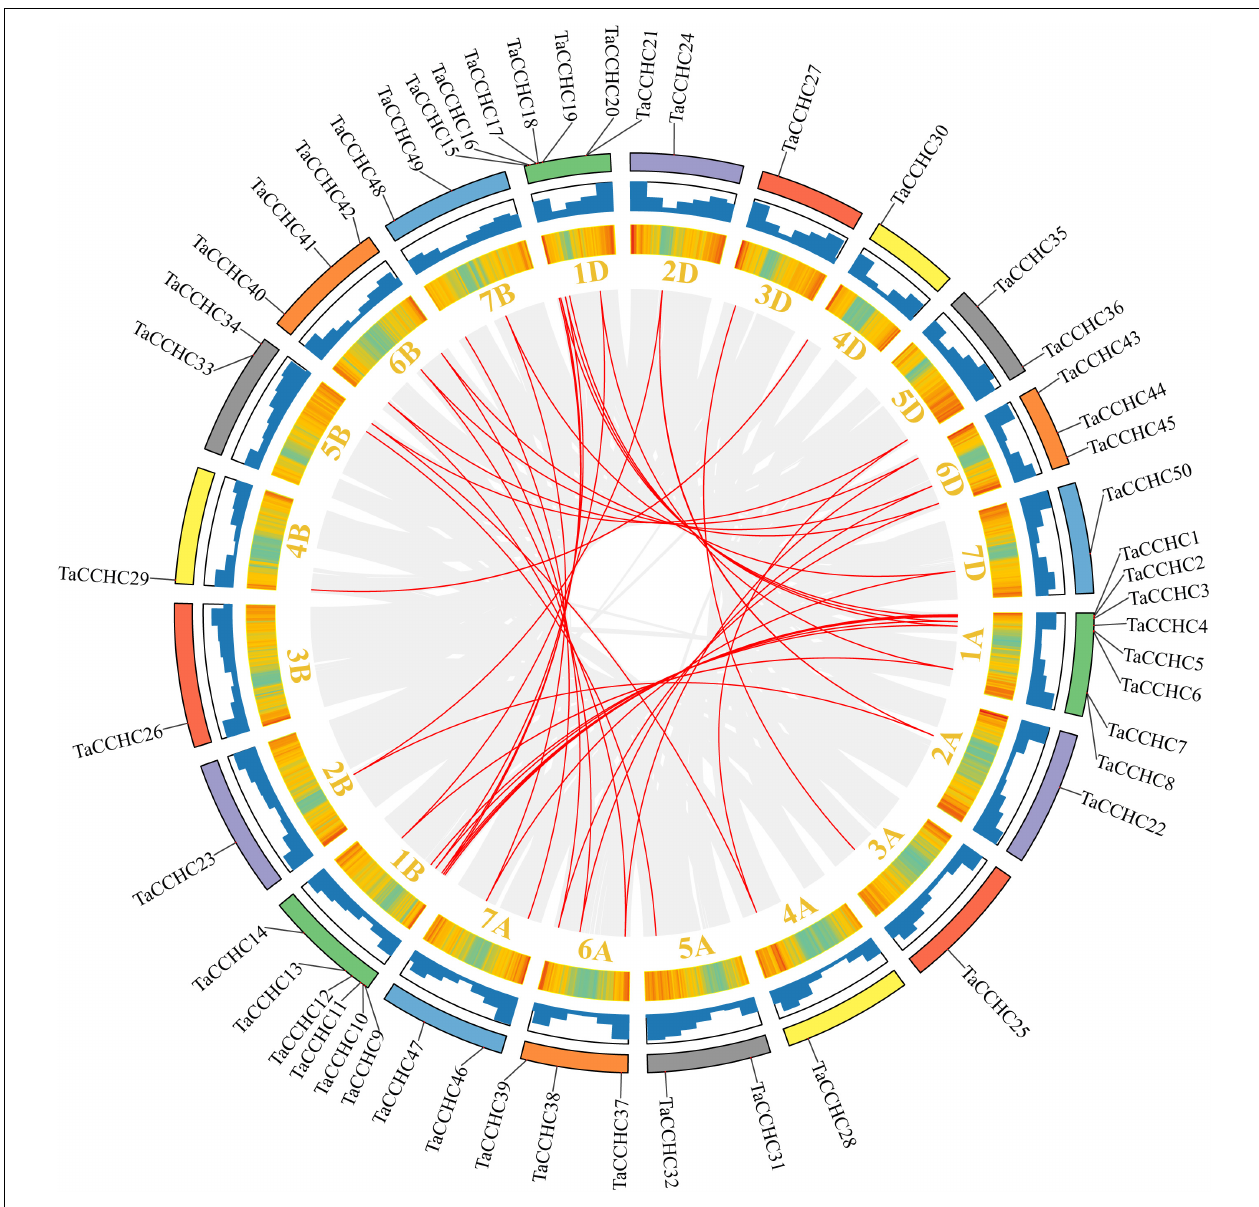
FIGURE 5 | Synteny analysis of the CCHC-ZFP family in wheat. The gray lines indicate all synteny blocks within the wheat genome, while the red lines represent duplicated CCHC-ZFP gene pairs. Wheat chromosomes are displayed by rectangles with different colors, and the heatmaps and histograms along the rectangles show the gene density of each